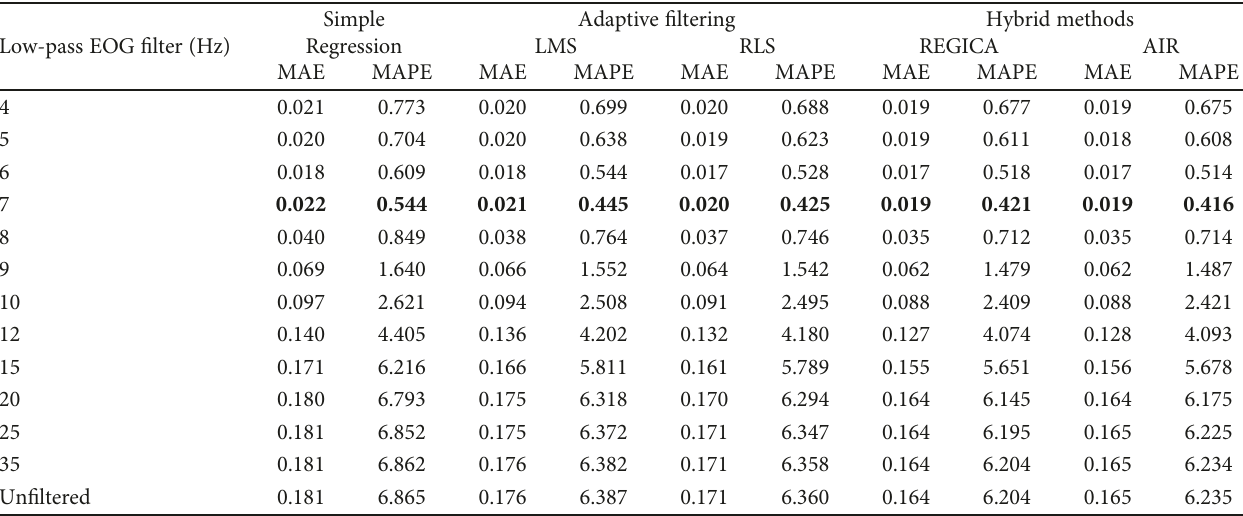
Table 8: Mean absolute error (MAE) and mean absolute percentage error (MAPE) values in alpha frequency band (mean of all EEG channels and mean of all simulated